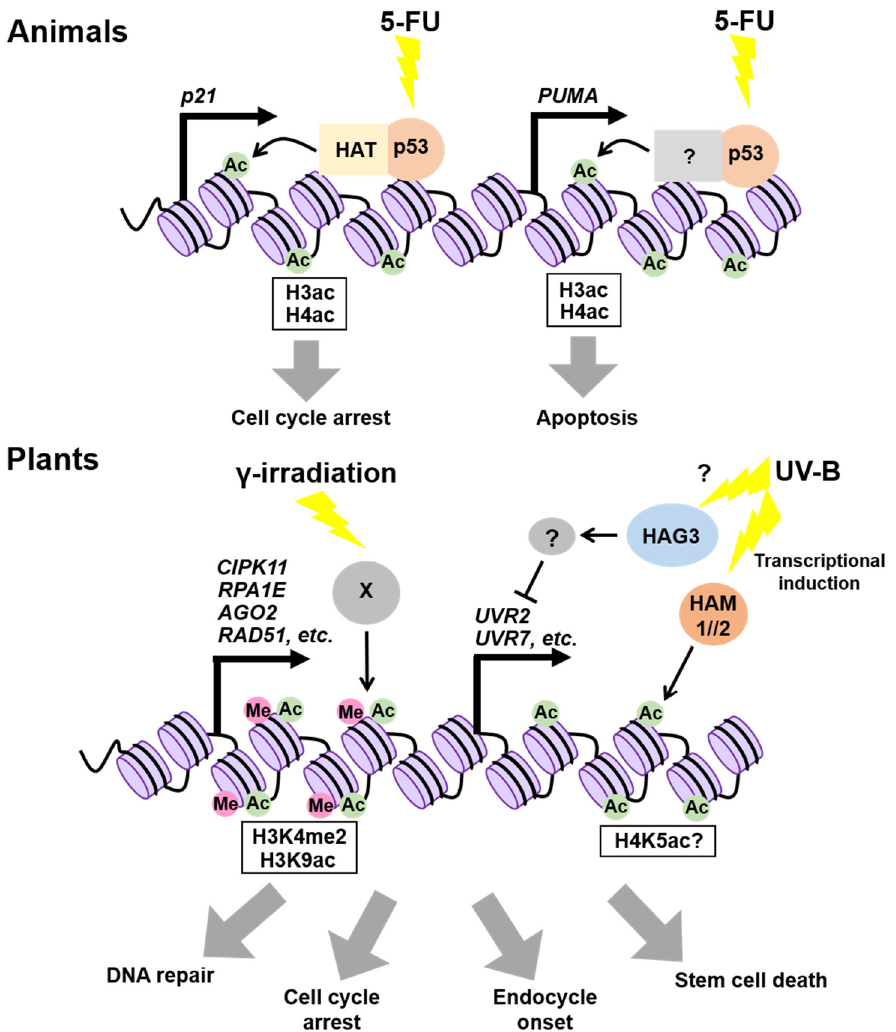
Figure 2. Epigenetic regulation of gene expression in response to genotoxic stress. In animal treated with 5-FU, p53 enhances the acetylation of histone H3 and H4 at the p21 and PUMA loci, thereby inducing cell-cycle arrest and apoptosis. In plants, H3K9 acetylation and H3K4 di-methylation become enriched at the promoters of DDR genes upon γ -irradiation. Ultraviolet (UV)-B upregulates HAM1 and HAM2 , thereby elevating the expression of UV-B-induced genes (e.g., UVR2 and UVR7 ) probably by increasing the H4K5ac level.